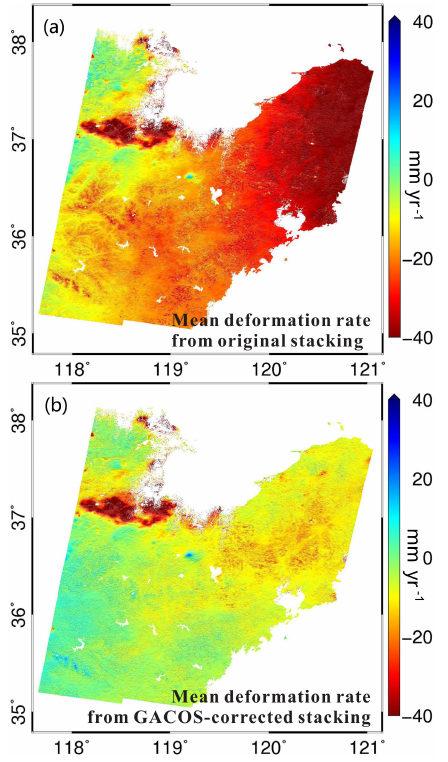
Figure 7. Deformation revealed by InSAR stacking without (a) and with (b) GACOS